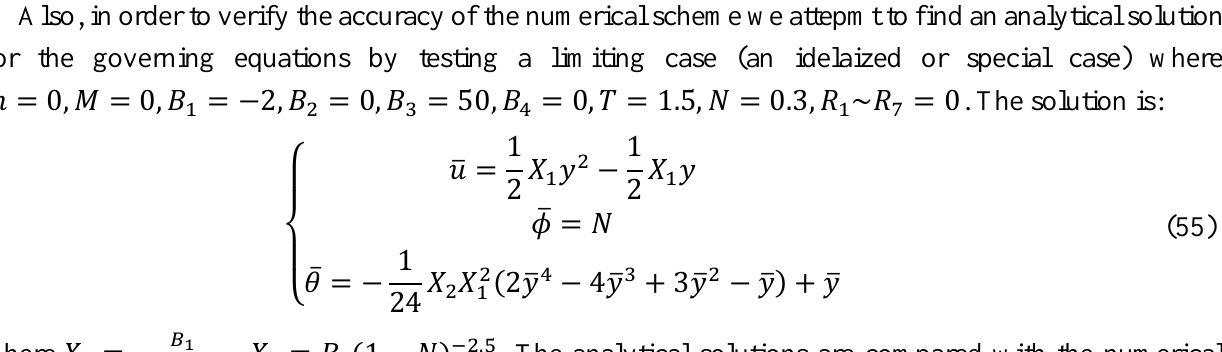
= −2, 𝐵 = 0.01, 𝐵 = 10, 𝐵 = 0.1, 𝑇 = 1.5, 1 2 3 4